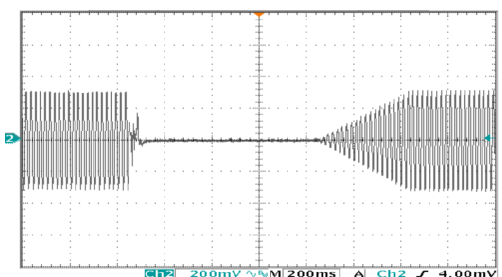
Figure 14. Master inverter´s voltage disturbance (DroopMains mode).